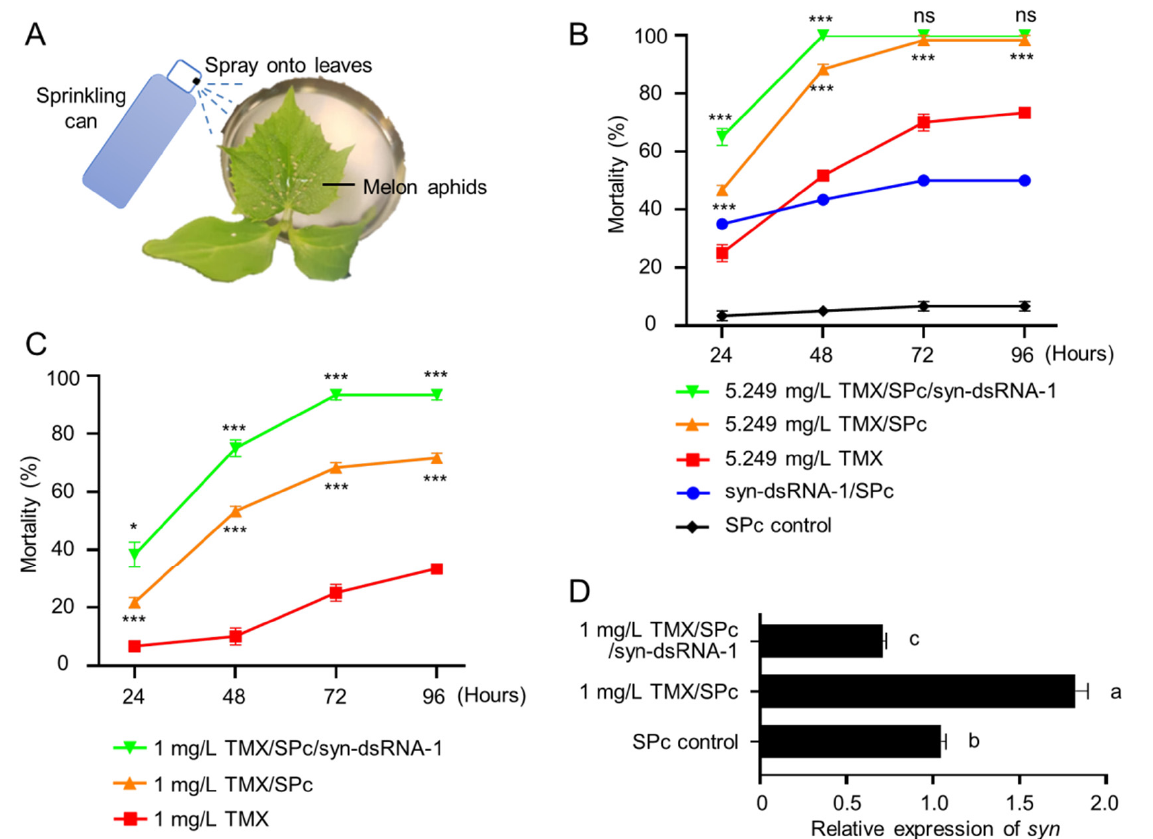
Figure 5. Co-delivery of syn-dsRNA and TMX enhanced the lethality rate. ( A ) Schematic diagram of spraying the insecticide. ( B ) syn-dsRNA and TMX had a synergistic effect at early time points. ( C ) syn-dsRNA and TMX had a synergistic effect at low levels of TMX. In ( B , C ), * above the green dot indicates significance by pairwise comparison of the mortality between TMX/SPc/syn - dsRNA and non-SPc treated aphids at each time point, while * underneath the orange dot is a comparison between TMX/SPc and TMX samples (Student’s t -test, *** p < 0.001 and * p < 0.05). ns, no significance. ( D ) synapsin was decreased in combination of syn-dsRNA and TMX. The letters on the right side indicate significant differences (Tukey’s multiple comparison test, p < 0.05).